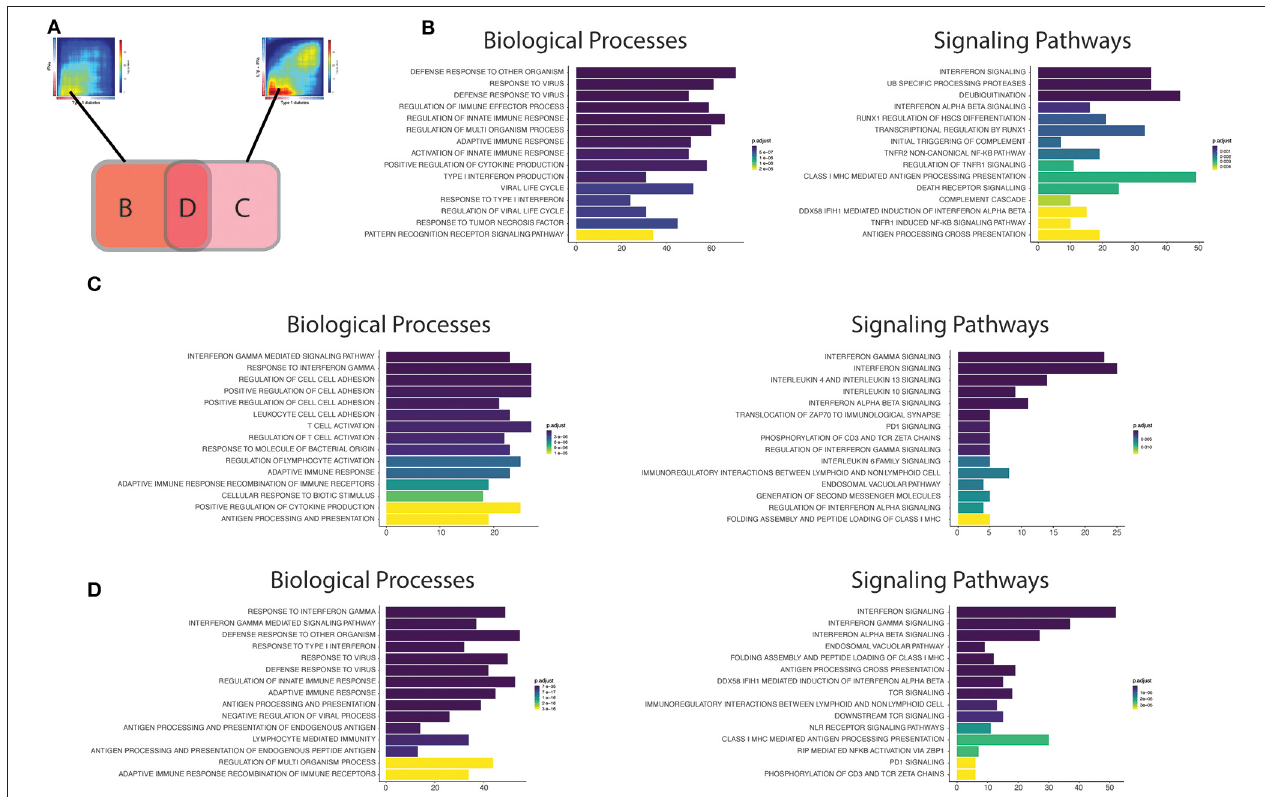
FIGURE 4 | Functional analysis of the transcripts overlapping beta cell datasets from T1D patients’ islets or cytokine-exposed human islets. (A) First, the up-regulated transcripts present in the intersection of RRHO maps comparing the T1D signature in beta cells against the IFN α (left) and IL1 β + IFN γ (right) signatures in human islets were identified. Next, these transcripts were divided in three different groups: ( B ) transcripts only present in the intersection between T1D vs. IFN α , ( C ) transcripts only present in the intersection between T1D vs IL1 β + IFN γ , ( D ) transcripts present in the intersection of all the three datasets (T1D, IFN α , IL1 β + IFN γ ). ( B–D) Biological processes (Gene Ontology) and signaling pathways (Reactome) enriched among the overlapping regions of the RRHO maps described above [ (B) only T1D vs IFN α ; ( C) only T1D vs. IL1 β + IFN γ ; (D) T1D, IFN α and IL1 β + IFN γ ]. The y axis shows the 15 most significant genesets, while the x axis represents the total number of transcripts identified in each